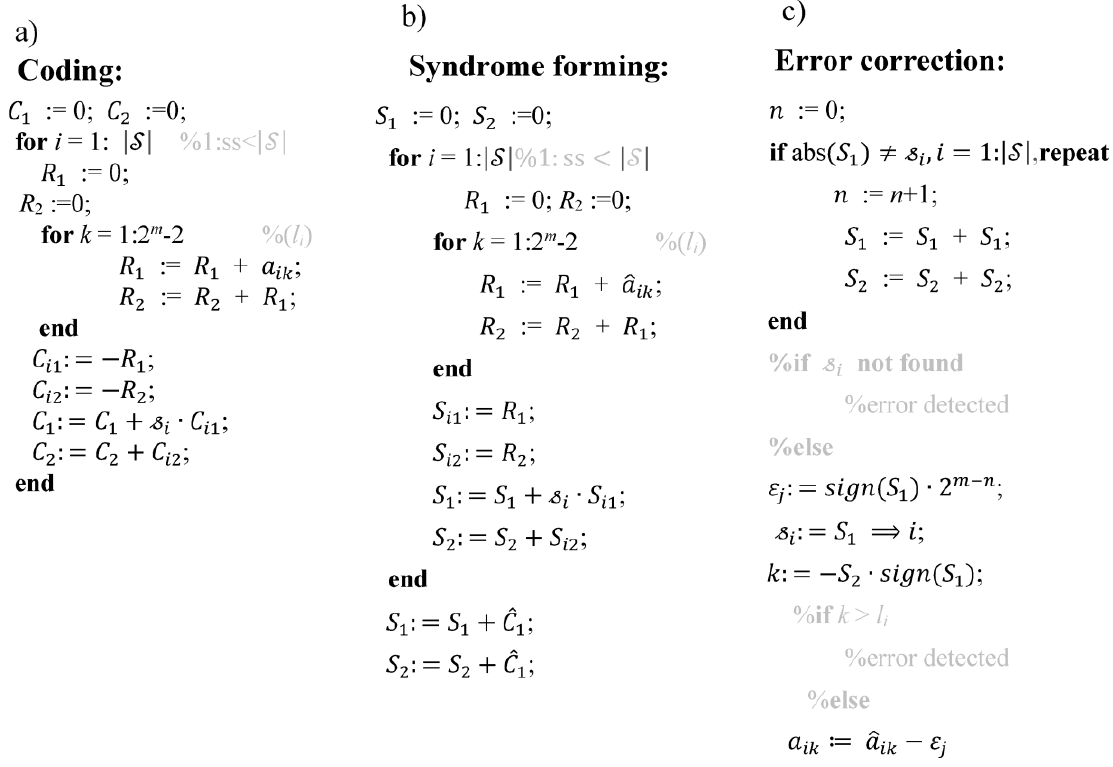
Figure 2. ( a ) Coding, ( b ) syndrome forming, and ( c ) error-correcting procedures. The coding procedure requires two ad- ditions per information symbol, and two additions, two negations, and one multiplication per sub-word. The splitting control symbols C i 1 and C i 2 are byproducts of coding procedure. Text in gray marks the changes due to the truncation and shortening described in Sections 3.3 and 3.4. l i —length of the i th sub-word; ss—number of sub-words.